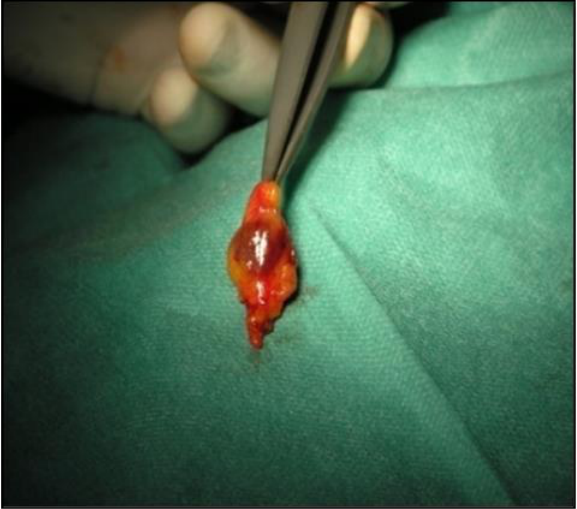
Figure 1. Sentinel node retrieved with superparamagnetic iron oxide (SPIO) .